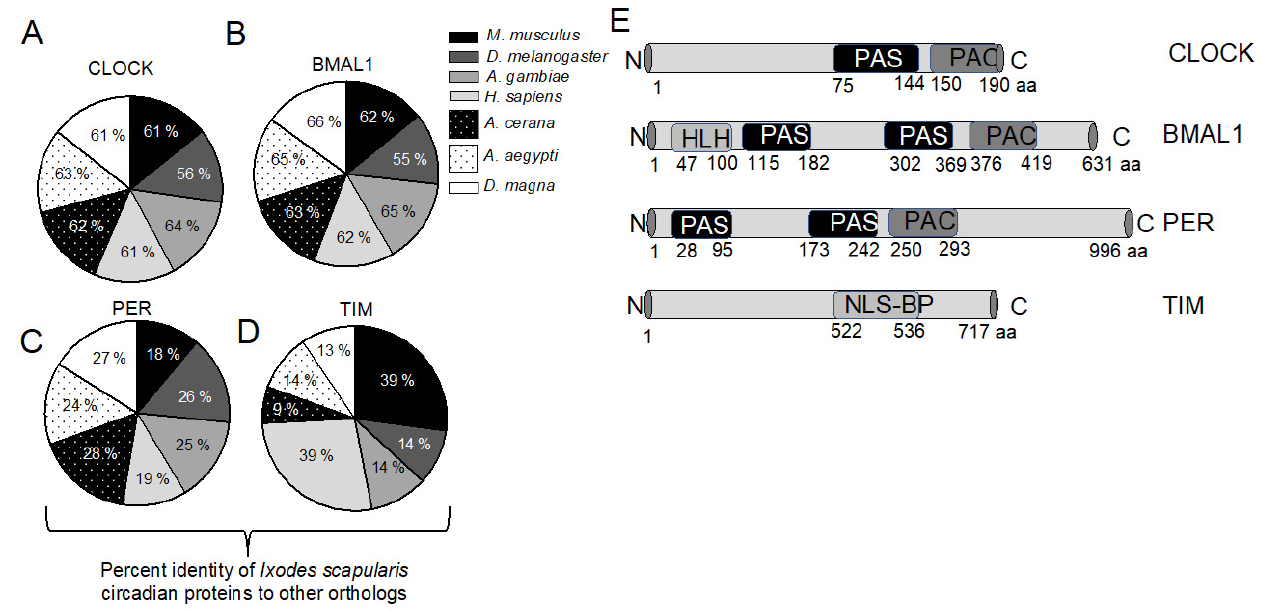
Figure 1. Ixodes scapularis circadian proteins share high percent of identity with mouse and human orthologs. ( A ) The pie chart shows the percent identity of I. scapularis circadian proteins CLOCK (A); BMAL1 ( B ); PERIOD ( C ); and TIMELESS ( D ) with M. musculus, D. melanogaster, A. gambiae, H. sapiens, A. cerana, Ae. aegypti and D. magna orthologs. The percent identities were determined using DNASTAR CLUSTALW alignment; ( E ) Domain analyses of I. scapularis CLOCK, BMAL1, PERIOD and TIMELESS. PAS indicates a Per-Arnt-Sim (PAS) domain, HLH indicates basic helix-loop-helix domain, NLSBP indicates Bipartite nuclear localization signal and PAC indicates motif C-terminal to PAS domain. Amino acid number corresponding to full length protein and each domain are shown below. N indicates N terminal and C denotes C terminal. Image is not drawn to the scale.